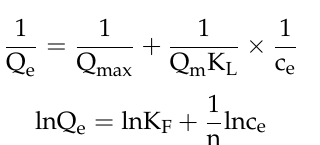
Table 1. Kinetic parameters for the adsorption of bisphenol A by ST-HEMA-GMA-BCD-NH 2. Lagergren’s Pseudo-First-Order